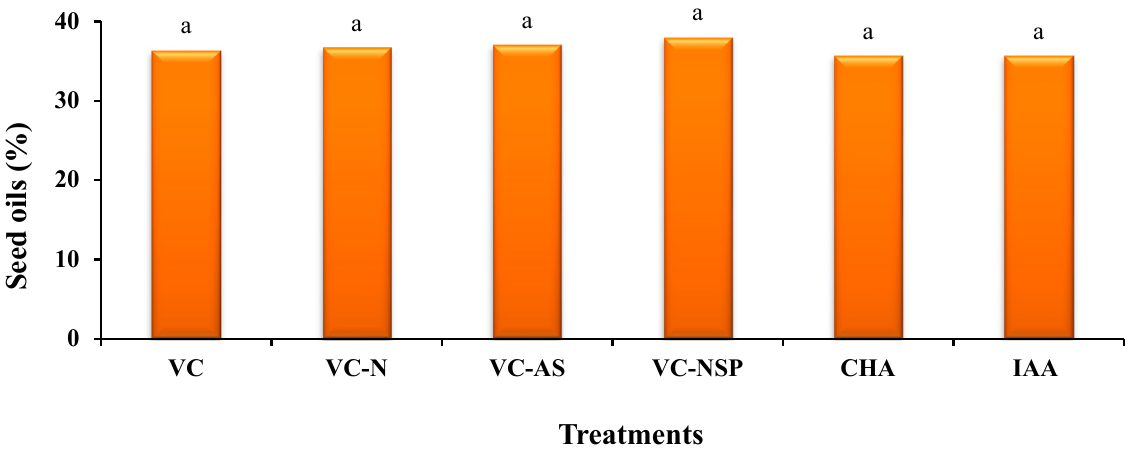
Figure 6. Comparison of average soil application of experimental treatments on seed oils at different treatments. Different letters in each figure show significant difference at p ≤ 0.05 by Duncan multiple range test. VC, VC without enrichment; VC-N, VC enriched with 1% nitrogen; VC-NSP, VC enriched with 1% nitrogen, 1% sulfur, and 1% phosphorus; VC-AS, VC enriched with Azotobacter chroococcum (21Az) + Pseudomonas fluorescens (Ps 59); CHA, Commercial humic acid; IAA, Indole-3-acetic acid.